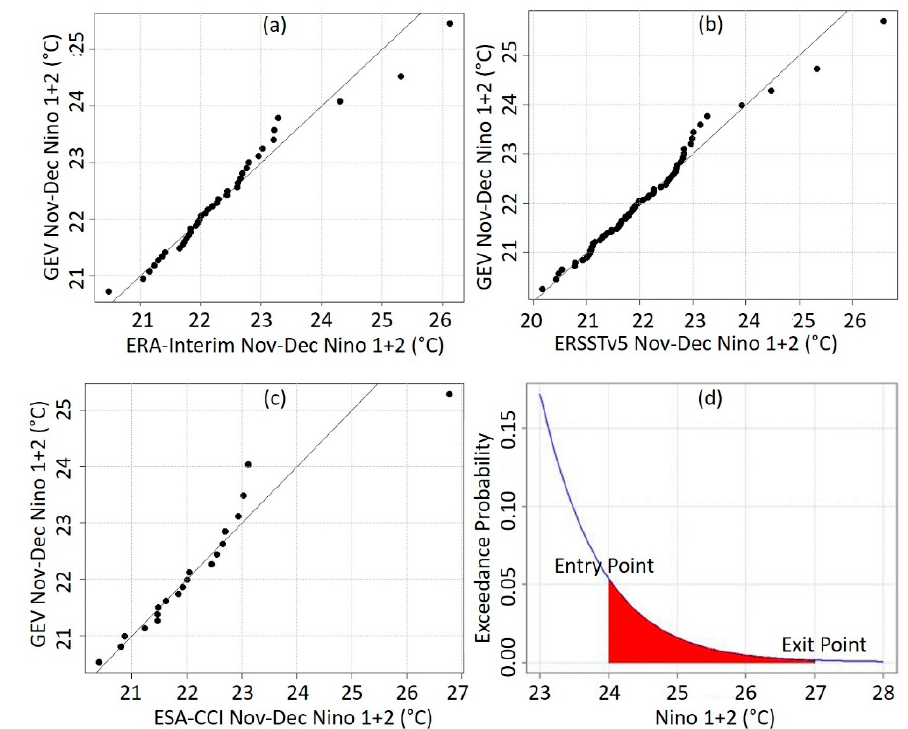
Figure 7. QQ (quantile-quantile) plot for assessing goodness of fit of the GEV distribution (the full-length data have been used here). The corresponding datasets are: ( a ) ERA Interim SST; ( b ) ERSSTv5; ( c ) ESA CCI SST. And, ( d ) the exceedance probability function (also known as complementary cumulative distribution function), demonstrating the probability that Niño1 + 2 greater than or equal to 24 °C is 0.053 (=return period 19 years).